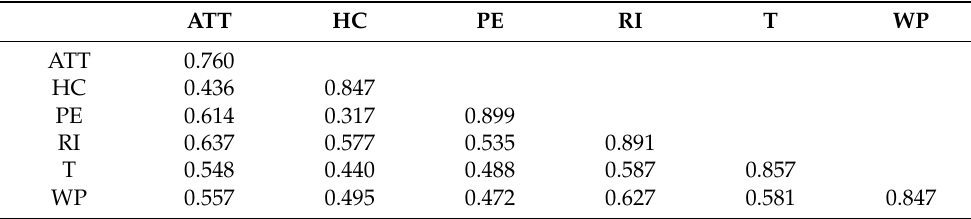
Table 3. Fornell–Larcker criterion.